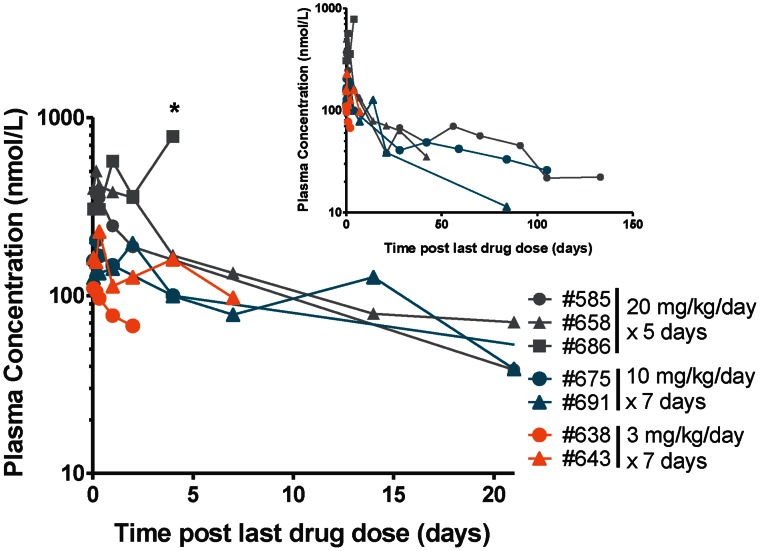
Plasma concentration-time profiles of DB829 following administration of the prodrug DB868 to infected vervet monkeys.The monkeys confirmed to have first stage HAT were administered DB868 orally, beginning at 7 days post-infection, at 20 mg/kg/day for 5 days, 10 mg/kg/day for 7 days, or 3 mg/kg/day for 7 days. The inset graph shows the extended DB829 profiles up to 150 days post-last DB868 dose. * denotes the time (4 days post-last drug dose) that monkey 686 was euthanized due to clinical morbidity (peritoneal abscesses).